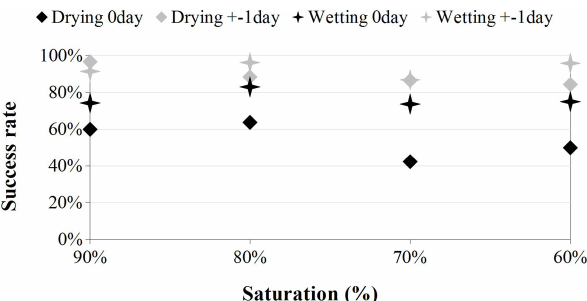
Figure 9. Day detection success rates. Drying 0day and wetting 0day show the number of identical day detection for both models during drying and wetting respectively. Drying ± 1 day and wet- ting ± 1 day show the success rate for day detection when there is less than 1 day difference between the two